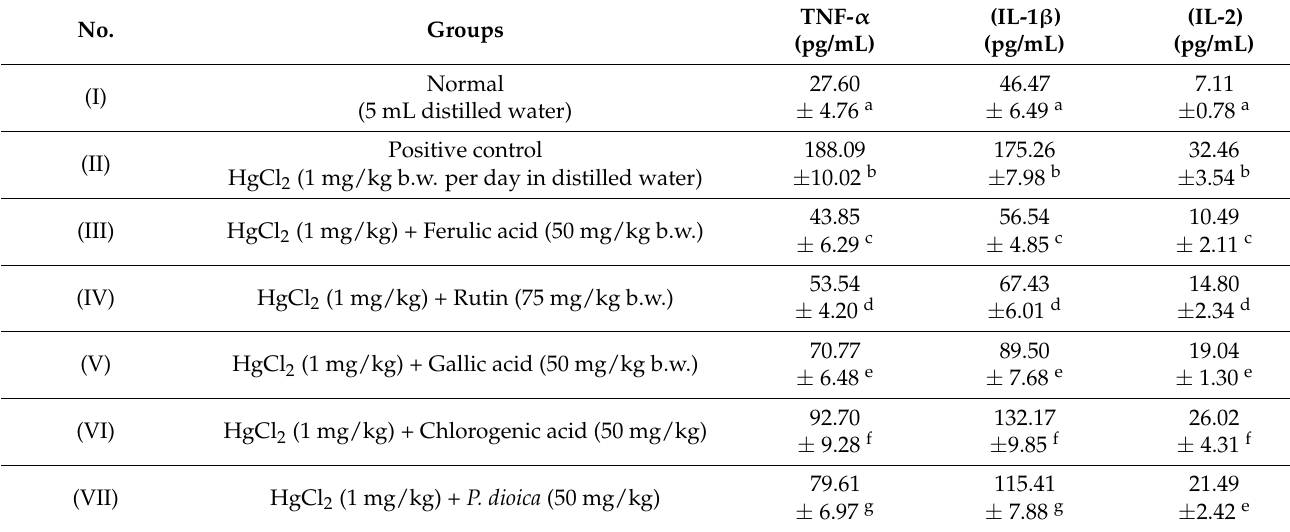
Values represent the mean ± SE ( n = 10). Data shown are mean ± standard deviation of the number of observations within each treatment. Data followed by the same letter (a, b, c, d, e, f, and g) within the same parameter are not significantly different at p ≤